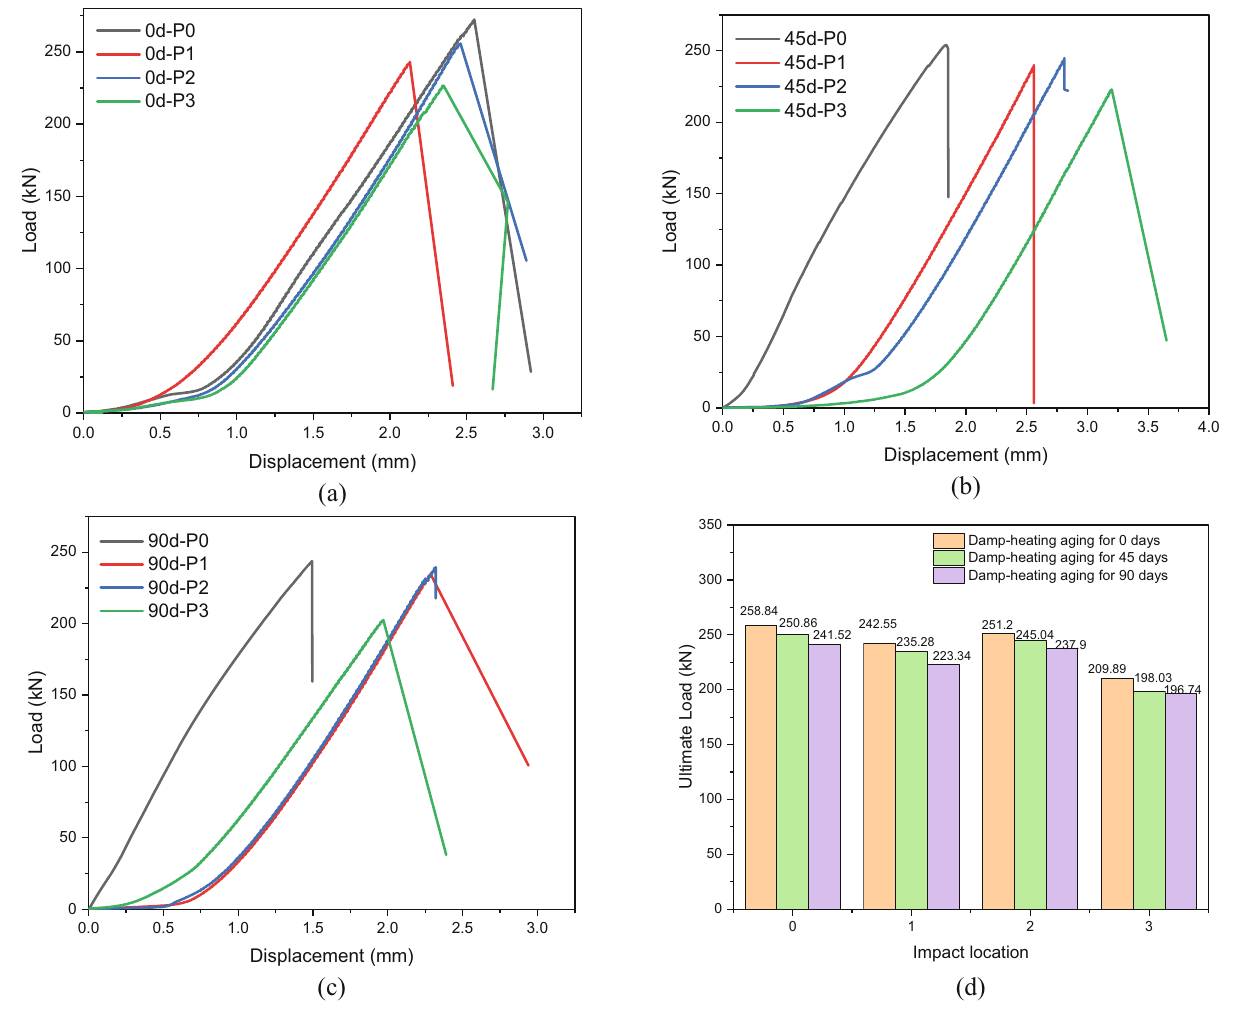
Figure 9: Load – displacement curves of specimens under CAI. ( a ) aging for 0 days; ( b ) aging for 45 days; ( c ) aging for 90 days; and ( d ) peak